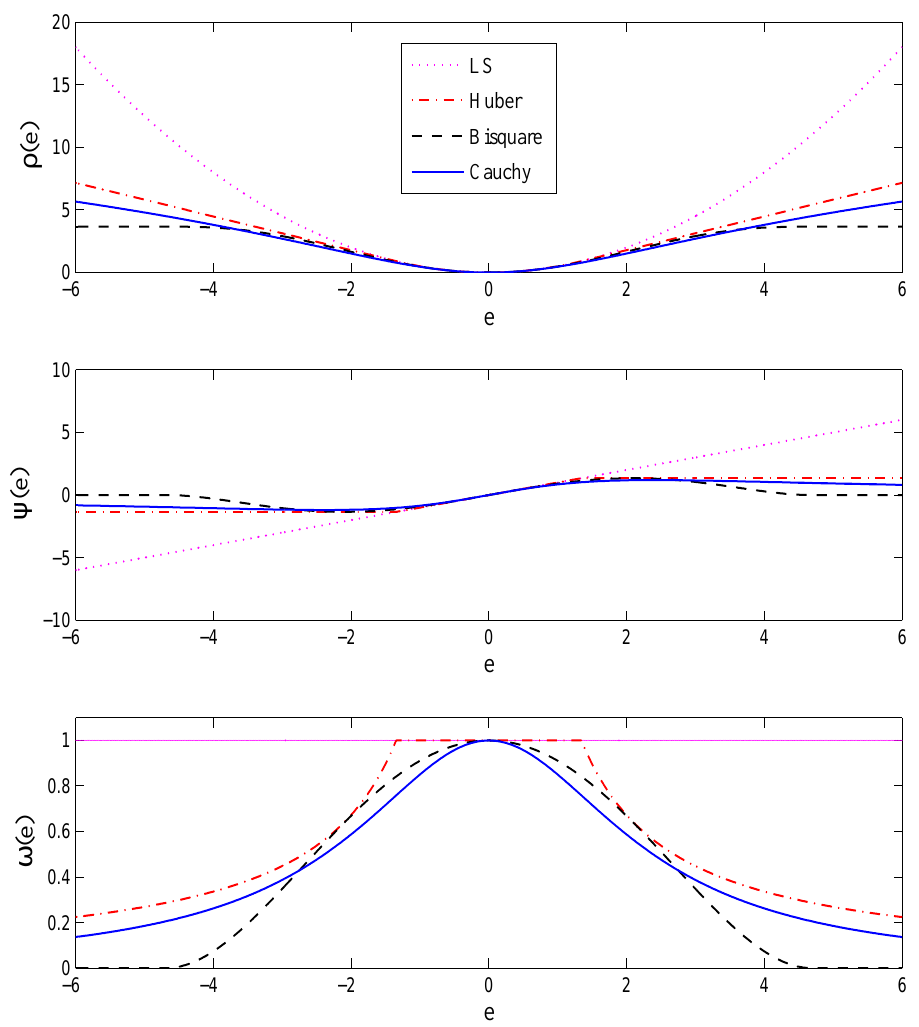
Figure 1. The functions ρ ( e ) (upper plot), ψ ( e ) (middle plot) and w ( e ) (lower plot) for the ordinary least-squares and three commonly-used robust functions, namely Huber, Bisquare and Cauchy.